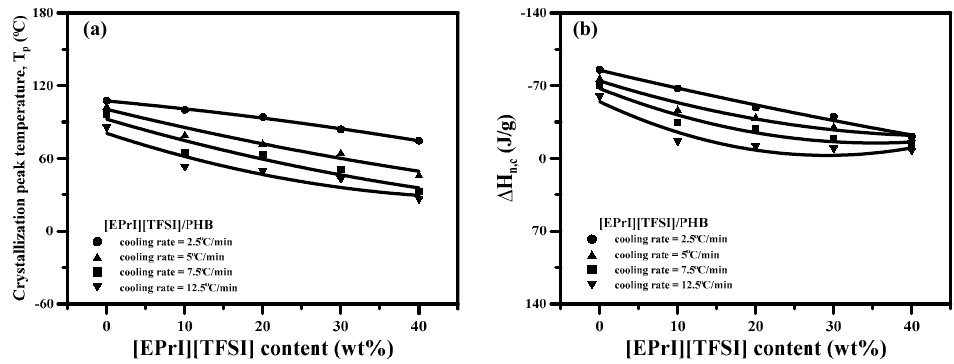
Figure 6. ( a ) Plot of T p -v.s.-[EPrI][TFSI] content in the blends with a different cooling rate; and ( b ) plot of ∆ H n,c -v.s.-[EPrI][TFSI] content in the blends with a different cooling rate.